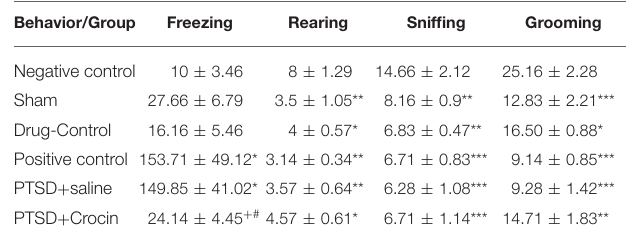
TABLE 1 | Forward and Reverse Sequences of RT-PCR Primers. Target gene